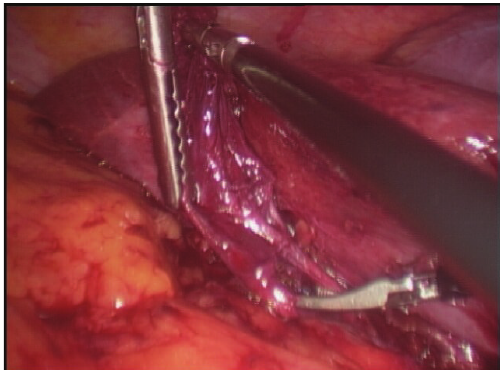
Figure 4: Anterograde dissection down to infundibulum presents structures in Calot’s triangle and allows demonstration of Strasberg’s critical view of